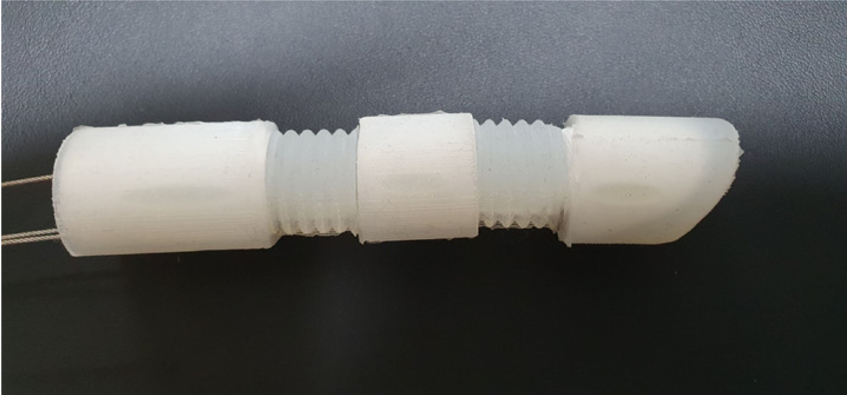
Figure 2. A prototype of the variable-stiffness structure.